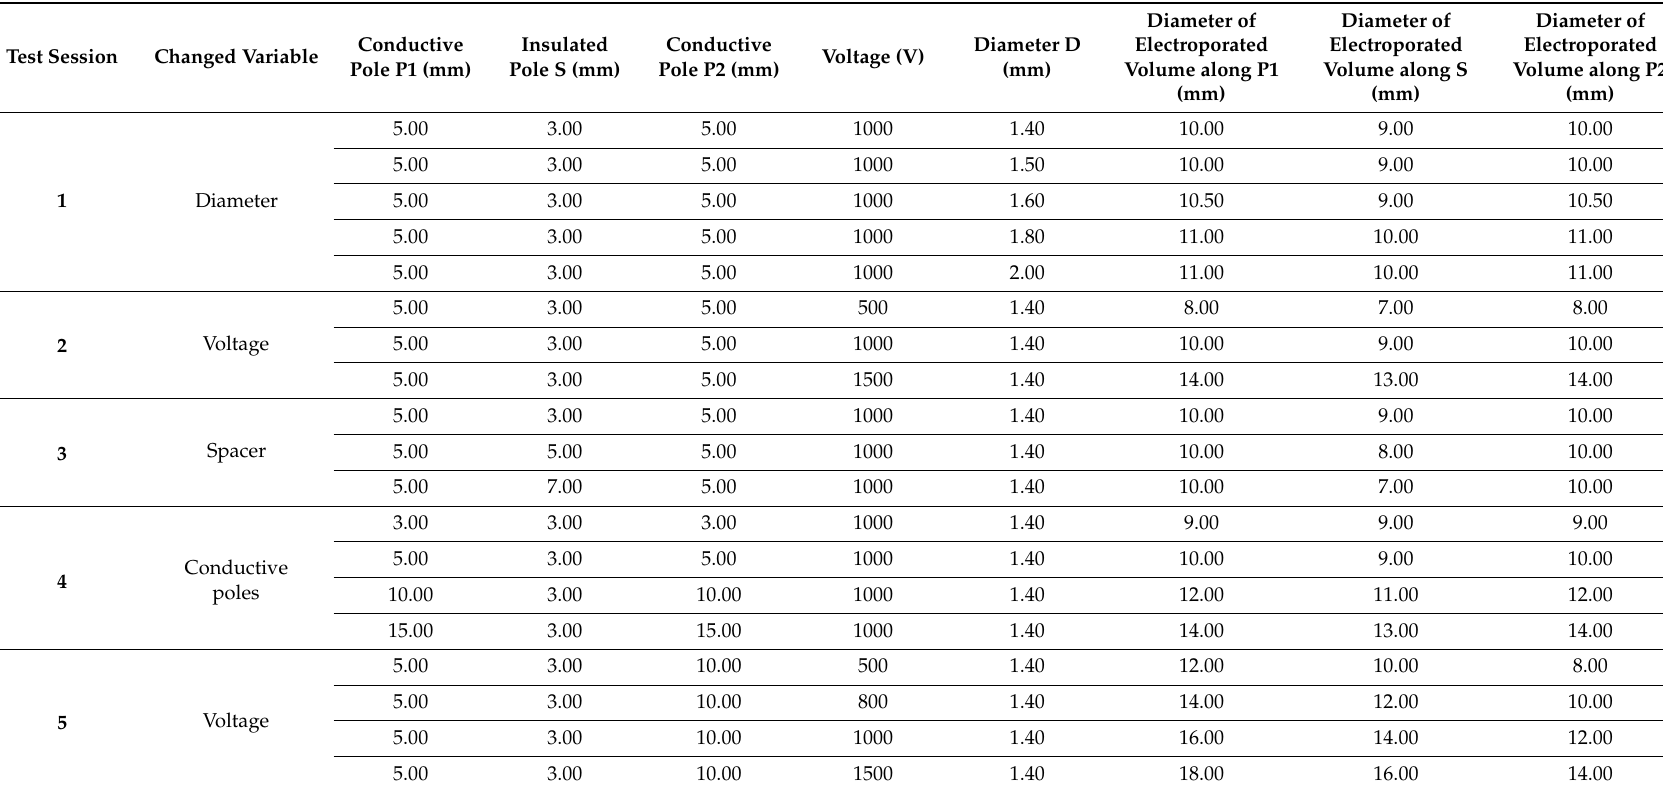
Table 1. Tests carried out with Comsol Multiphysics ® software for the analysis of the electric field distribution. In bold are the values changed in each test. Symmetric geometry is analyzed in tests 1–4, and asymmetric geometry is analyzed in tests 5–8. Values of maximum diameters obtained after electroporation are showed in the last three